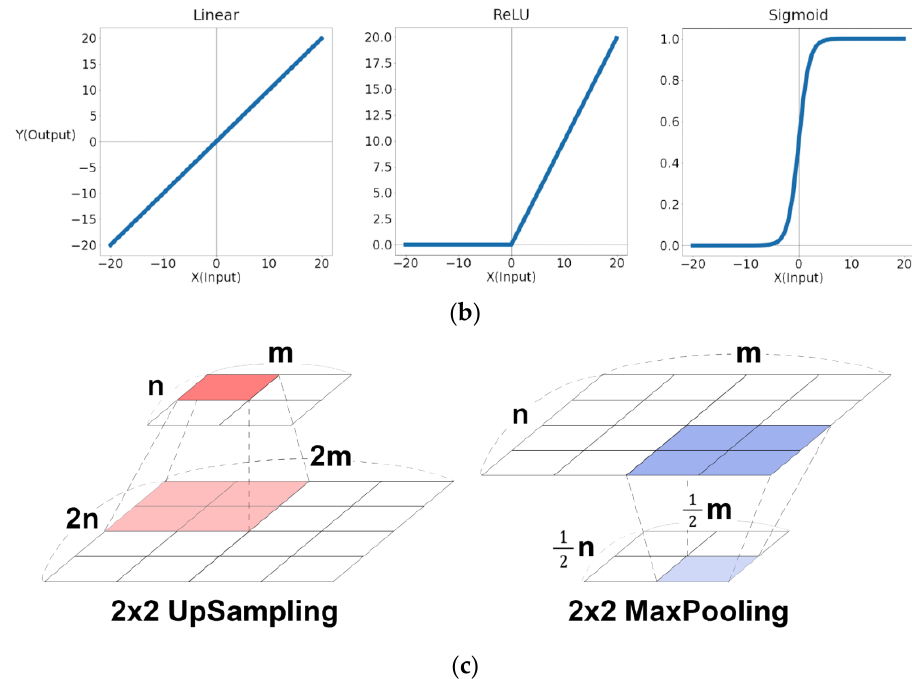
Figure 1. U-net and operations. ( a ) The architecture of U-net. ( b ) Graphs of linear, ReLU, and sigmoid activation functions. ( c ) Processes of upsampling and maxpooling.